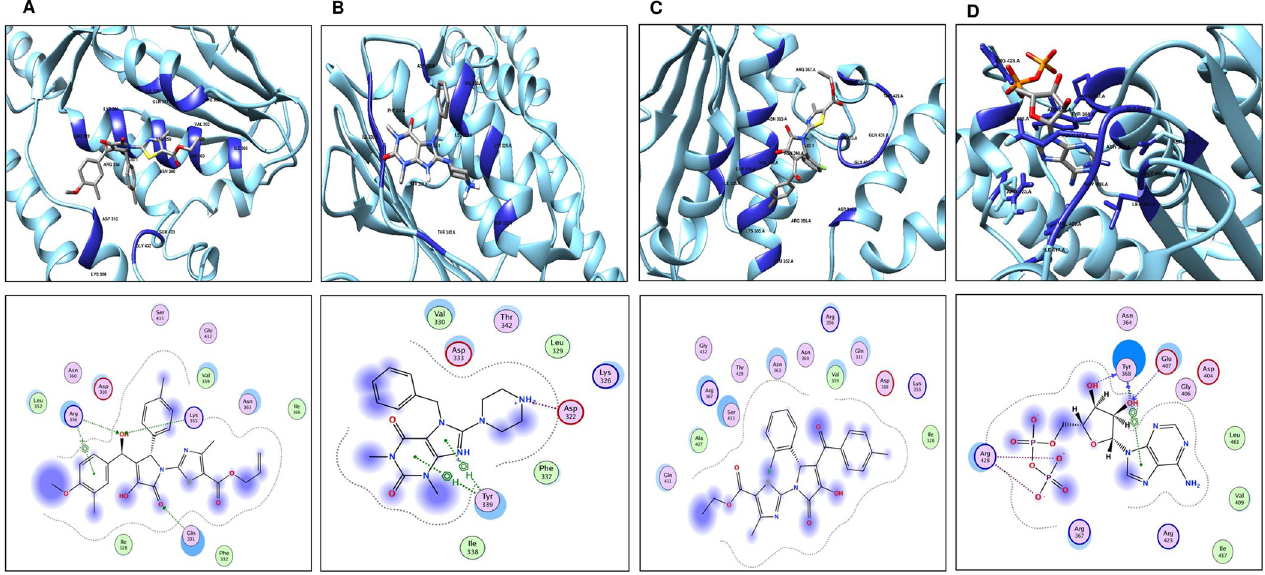
Fig 7. Redocked compound incorporating the modelled protein: (A) For ZINC09185674, (B) ZINC03839141, (C) ZINC00631248 and (D) Reference Protein.